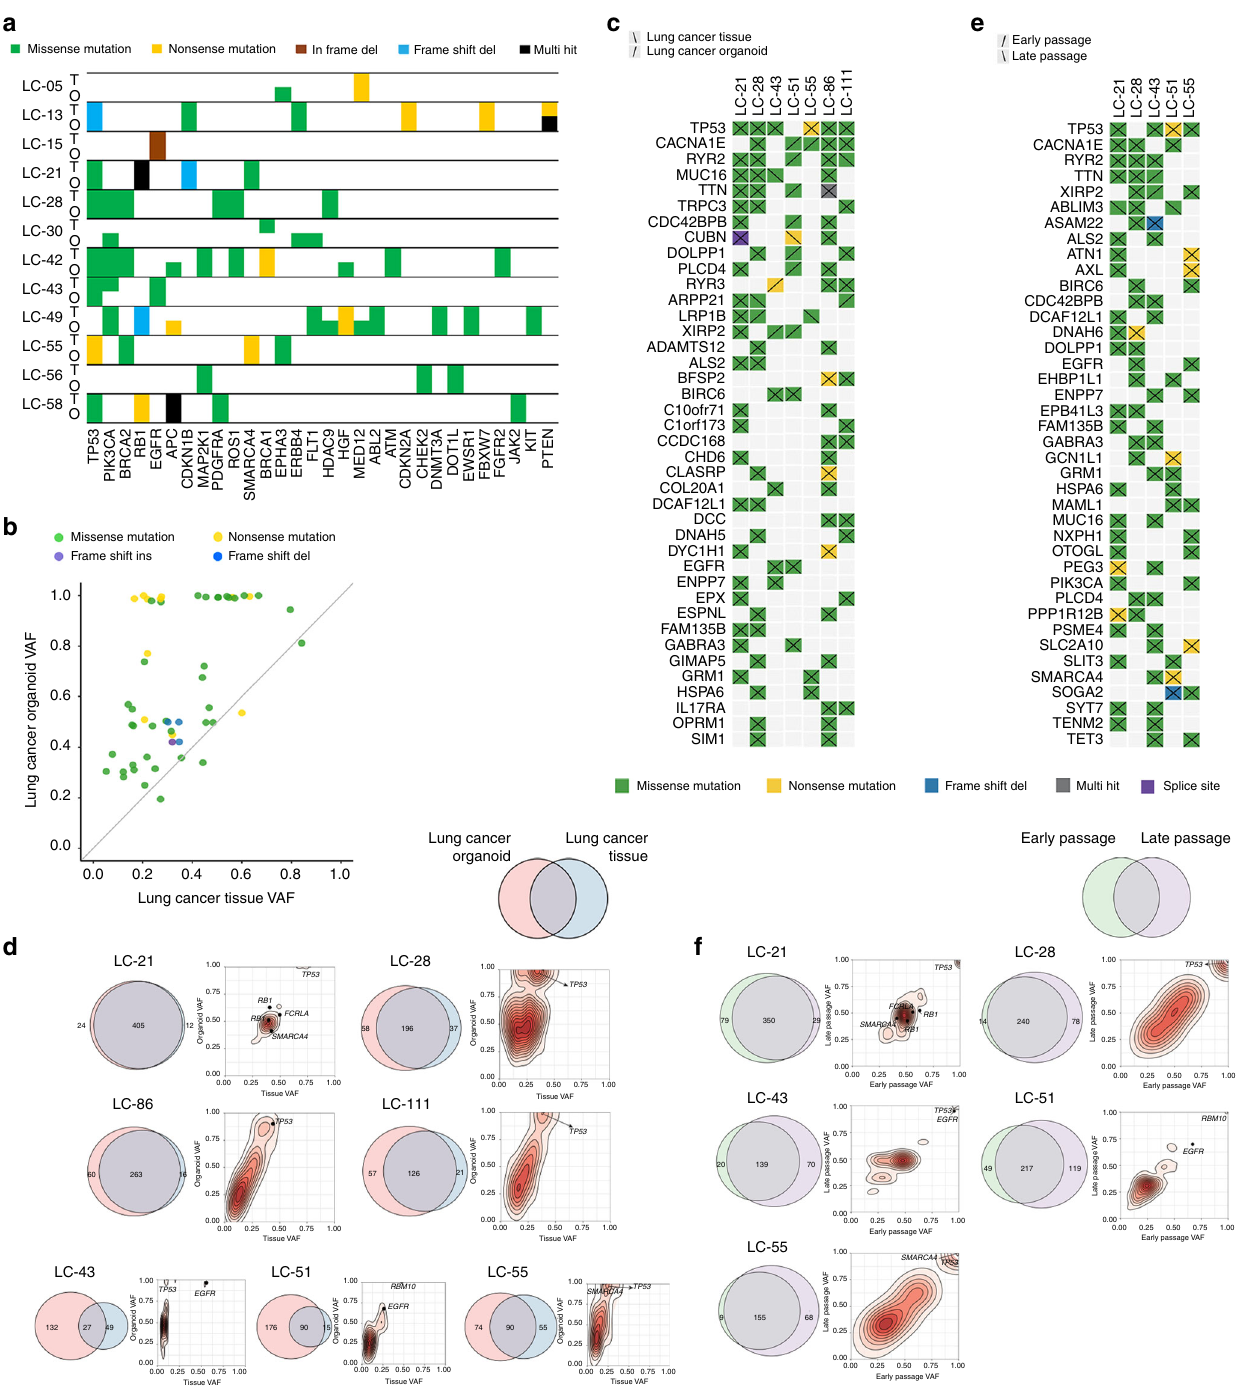
Fig. 3 LCOs retain the genetic characteristics of the original tissues after long-term cultured. a Heat-map analysis of the top 30 mutations in LCOs and their corresponding LC tissues. O LCO, T patient tissue. b Comparison of VAF of genetic alterations detected in LCOs and LC tissues. c Heatmap showing somatic mutations affecting cancer genes in LC tissues and paired LCOs. d Venn diagrams indicating the number of somatic mutations present in each LC tissues and their paired LCOs. e Heatmap showing somatic mutations affecting cancer genes in early passage and late passage organoids. f Venn diagrams indicating the number of somatic mutations present in early passage and late passage